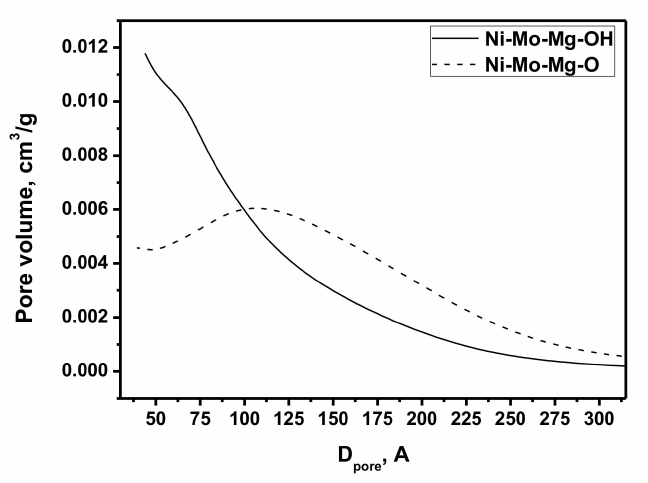
Figure 2. Pore size distributions (Barrett-Joyner-Halenda (BJH) method) of the prepared samples.